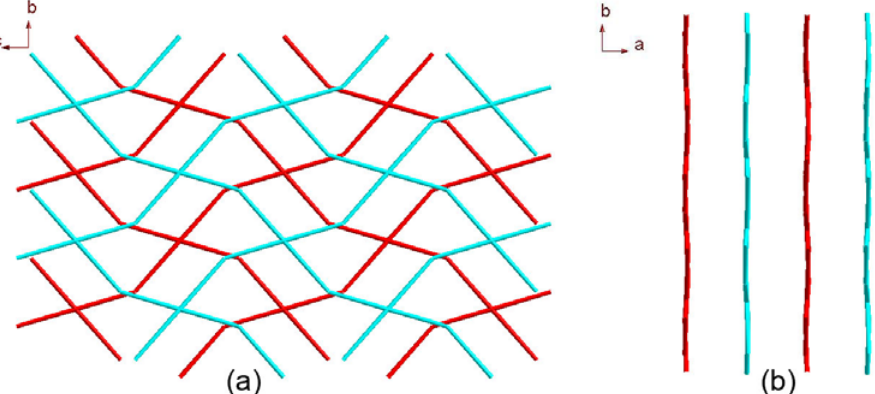
] coordination layer along ( a ) the a axis and ( b ) the c axis. 4 n